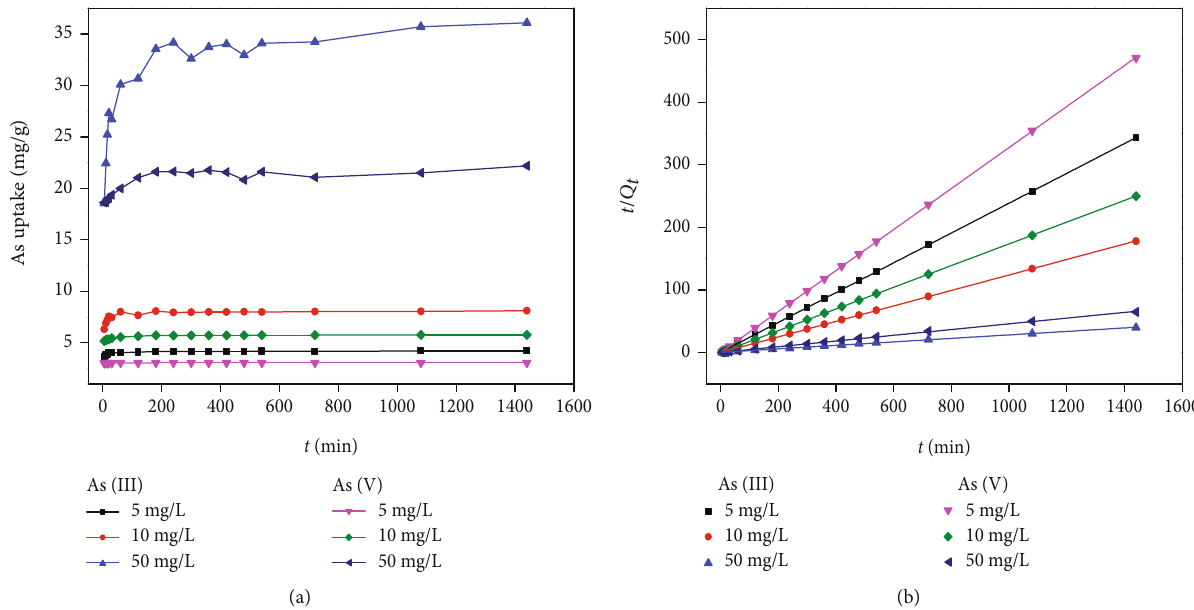
Figure 9: Kinetics of arsenic adsorption by Fe/Mn-C-LDH (a). Fitted adsorption isotherms (b). Table 5: The pseudo- fi rst-order and pseudo-second-order models for arsenic on Fe/Mn-C-LDH. Pseudo- fi rst-order Concentration (mg/L) Q e